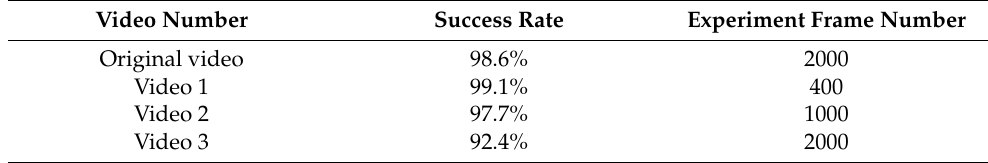
Figure 15. The effects of electronic stabilization in different environments: ( a ) in cloudy weather conditions; ( b ) the sunlight reflecting heavily on the sea surface; ( c ) a mountainous background; ( d ) in a severe storm. Table 1. The success rate of the electronic stabilization algorithm in different